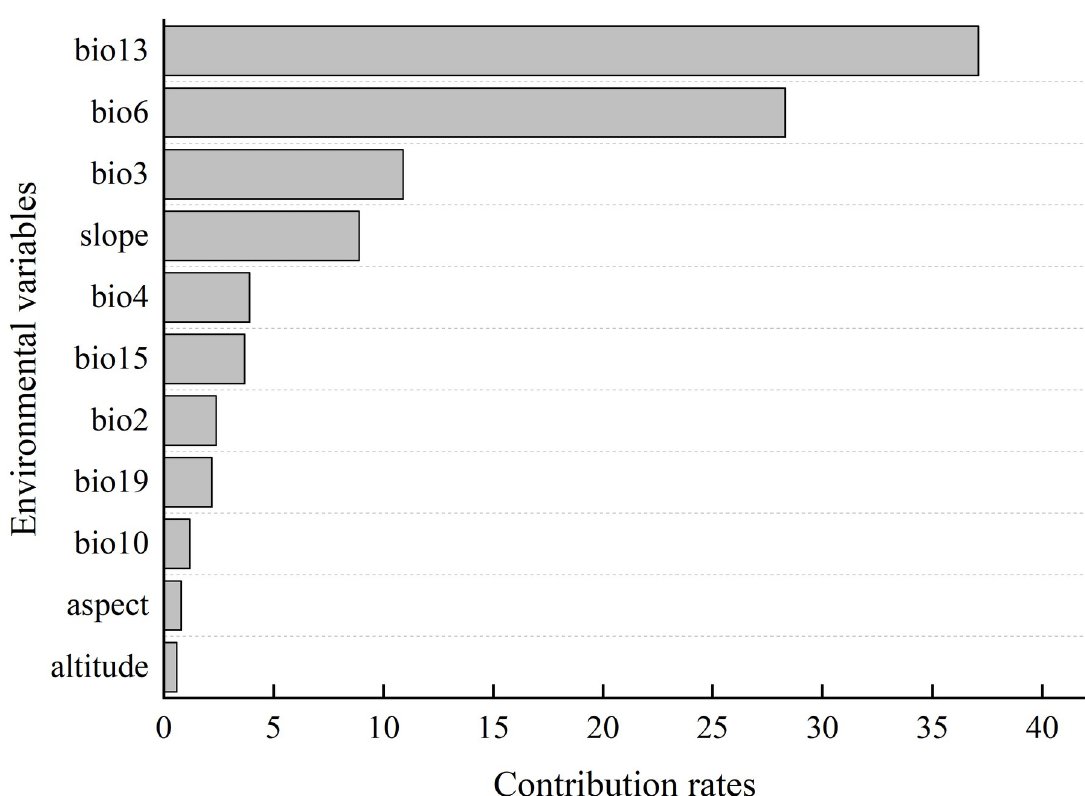
Fig 4. Contribution rate of environmental variables on the distribution of P . tatarinowii .